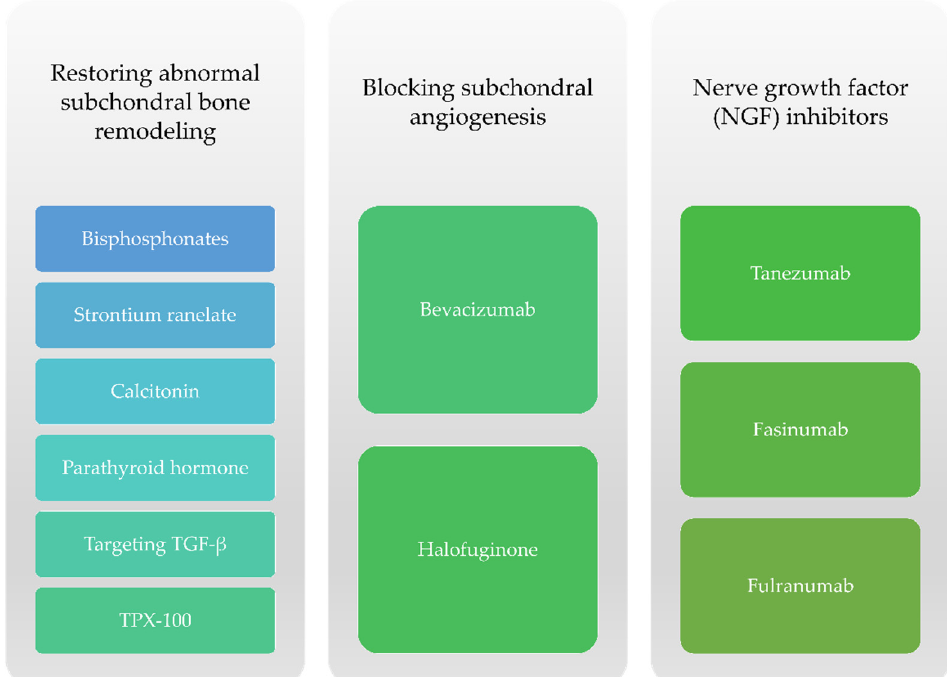
Figure 4. Therapeutic options targeting subchondral bone remodeling for knee OA.